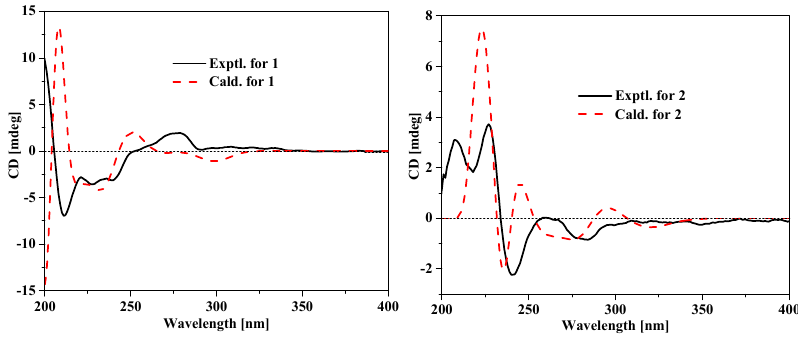
Figure 3. Experimental and calculated ECD spectra for compounds 1 and 2 .